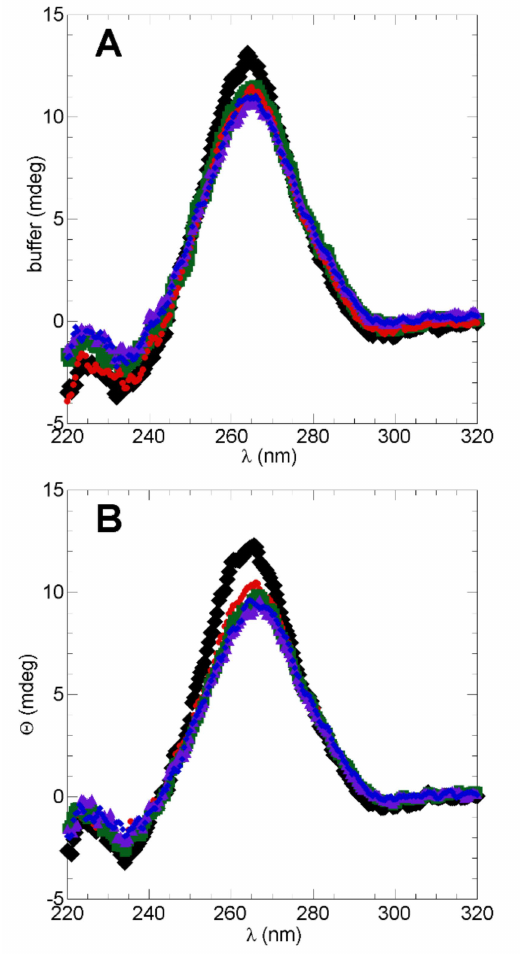
Figure 6. UV CD Spectra of tRNA Ala before and after h-ANG Cleavage. CD spectra of 20 µ M tRNA Ala in 100 mM KCl, 1.0 mM MgCl 2 , 20 mM NaPi, pH 6.5, 25 ◦ C. Black = tRNA Ala in buffer; Green = tRNA Ala + wt h-ANG, Red = tRNA Ala + H13A h-ANG, Purple = tRNA Ala + W39C h-ANG, Blue = tRNA Ala + R121A h-ANG. ( A ). Spectra right after incubation for cleavage. ( B ). Spectra following cleavage and after applying a heating followed by a slow cooling step for possible structural